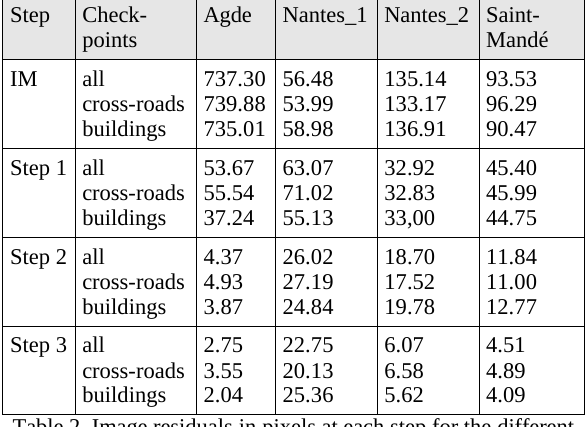
Table 2. Image residuals in pixels at each step for the different kinds of check-points IM indicates index map measured precision; step 1 is subsampled image registration by an homography (see Figure 5); step 2 is full-resolution image registration using road network only (see Figure 6 bottom left); step 3 is final registration using both buildings and roads (see Figure 6 bottom right)